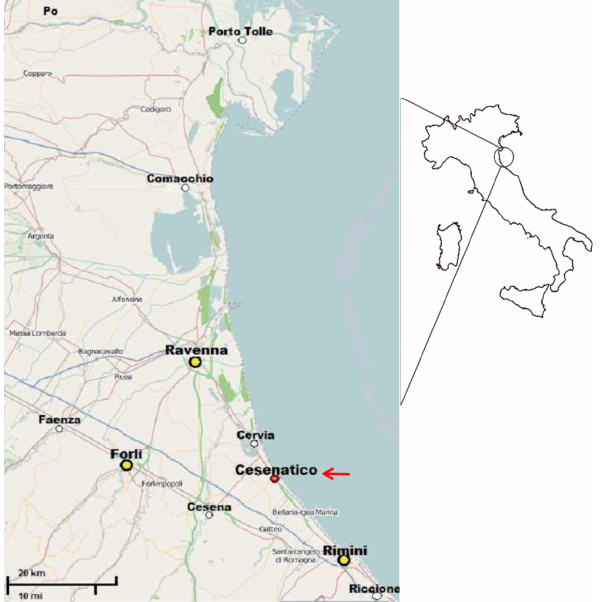
Figure 1. Location of Cesenatico on the coast of Emilia–Romagna and its position in Italy. The yellow points represent the three biggest cities in the area, while the white ones highlight some of the other large municipalities nearby (source: our elaboration from Open Street Map).